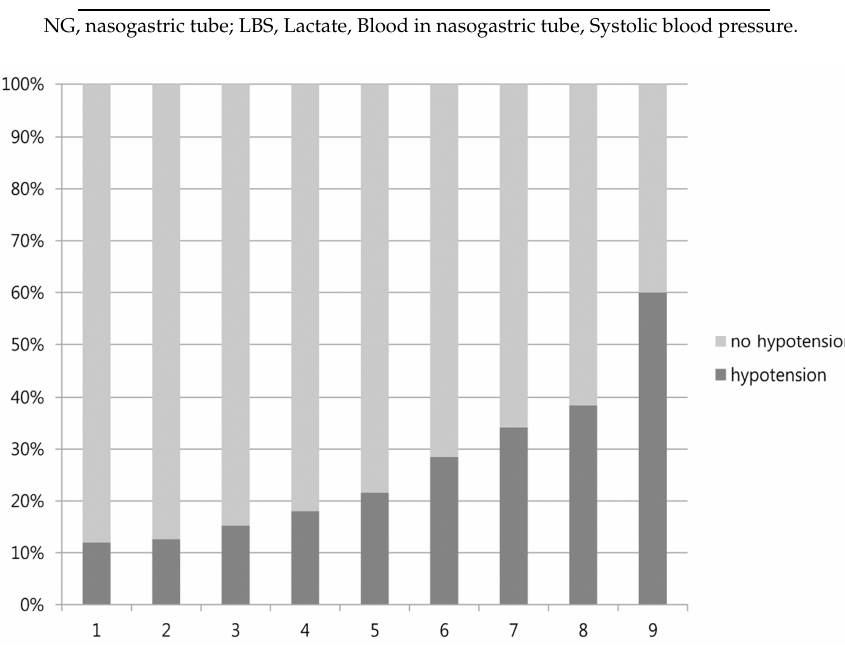
Figure 1. Observed occurrence of hypotension for the new scores in the development set. Table 3. Diagnostic performance in predicting the occurrence of hypotension in the development set (2012–2015; event n = 97/1046). Cutoff Point